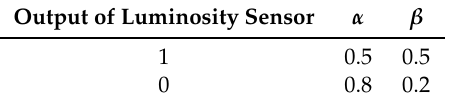
Table 6. Self-configuration of weighting parameter according to the luminosity sensor output.